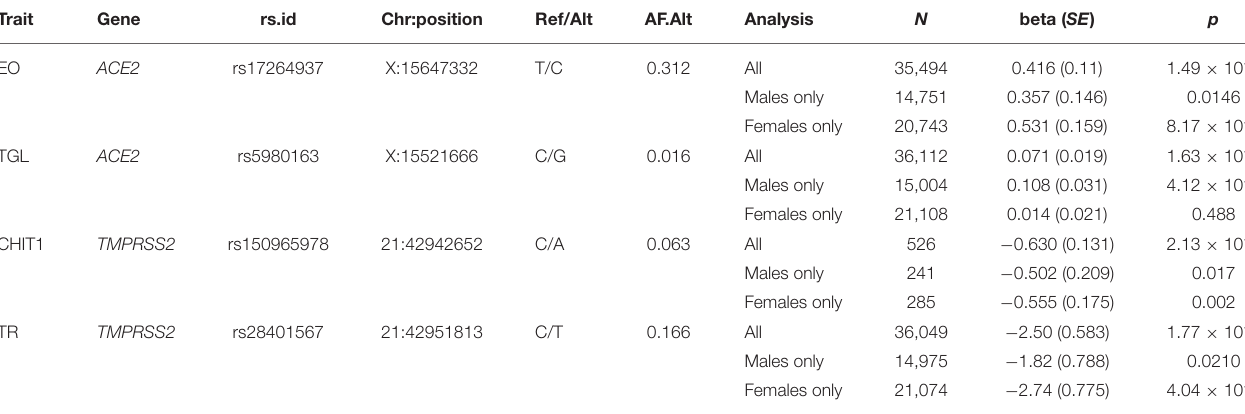
TABLE 1 | Most-significant associations with phenotypes at ACE2 and TMPRSS2 loci. Trait Gene rs.id Chr:position Ref/Alt AF.Alt EO